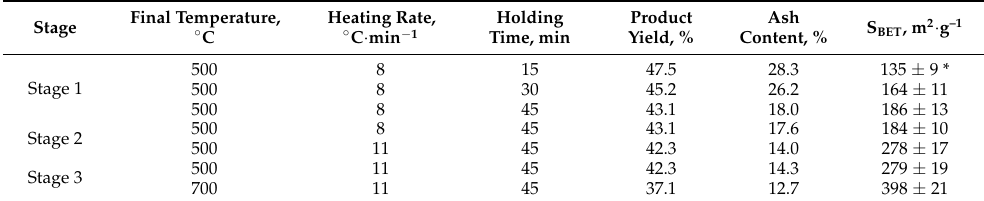
Table 1. Characteristics of biochar at different stages of experiment.